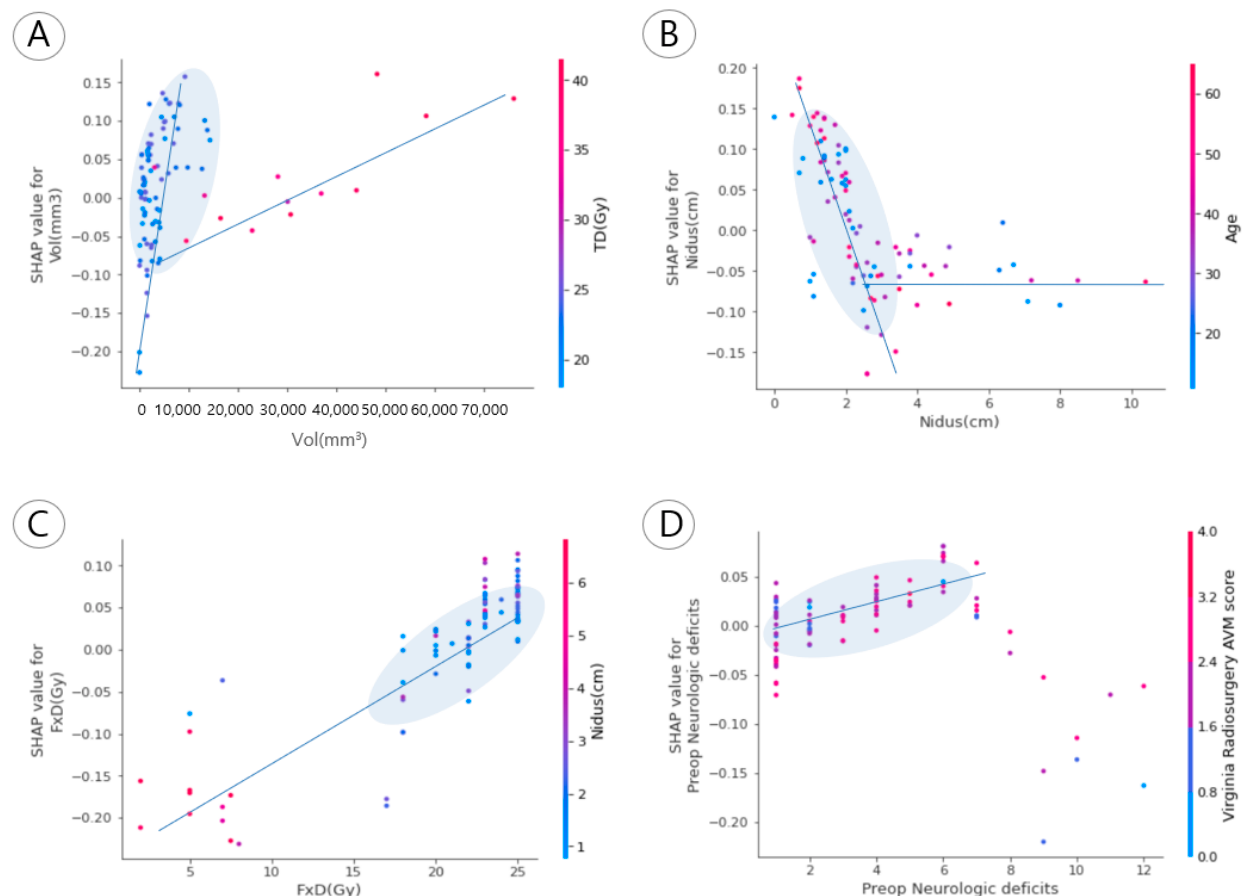
Figure 3. Factors highly associated with nidus obliteration in the correlation analysis. ( A ) Nidus volume (mm 3 ) vs. total dose, ( B ) Nidus size (cm) vs. age (years), ( C ) Fractional dose (Gy) vs. nidus size (cm), and ( D ) Preoperative neurological de fi cits vs. Virginia radiosurgery AVM score (VRAS). Note: Grey parts (dense regions of sample frequency), preoperative neurological de fi cit (1: head-